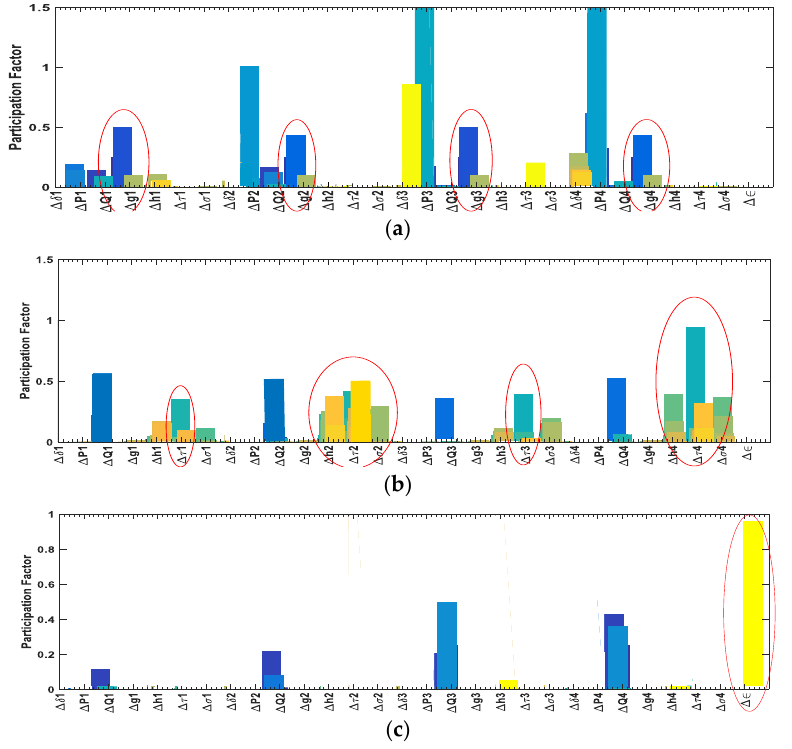
Figure 4. Participation factors of modes 6–9. ( a ) Mode 6; ( b ) Modes 7 and 8 and ( c ) Mode 9. Figure 4a indicates that ∆ δ i , ∆ P i and ∆ g i of every DG unit actively participated in the oscillation caused by mode 6, revealing the direct participation of these states of all the DG units in the stability. As ∆ g i is the state variable for the DSC as in Equation (3) it is remarkably affected by the secondary controller gains D fi and D Pi and thus affects the stability of the